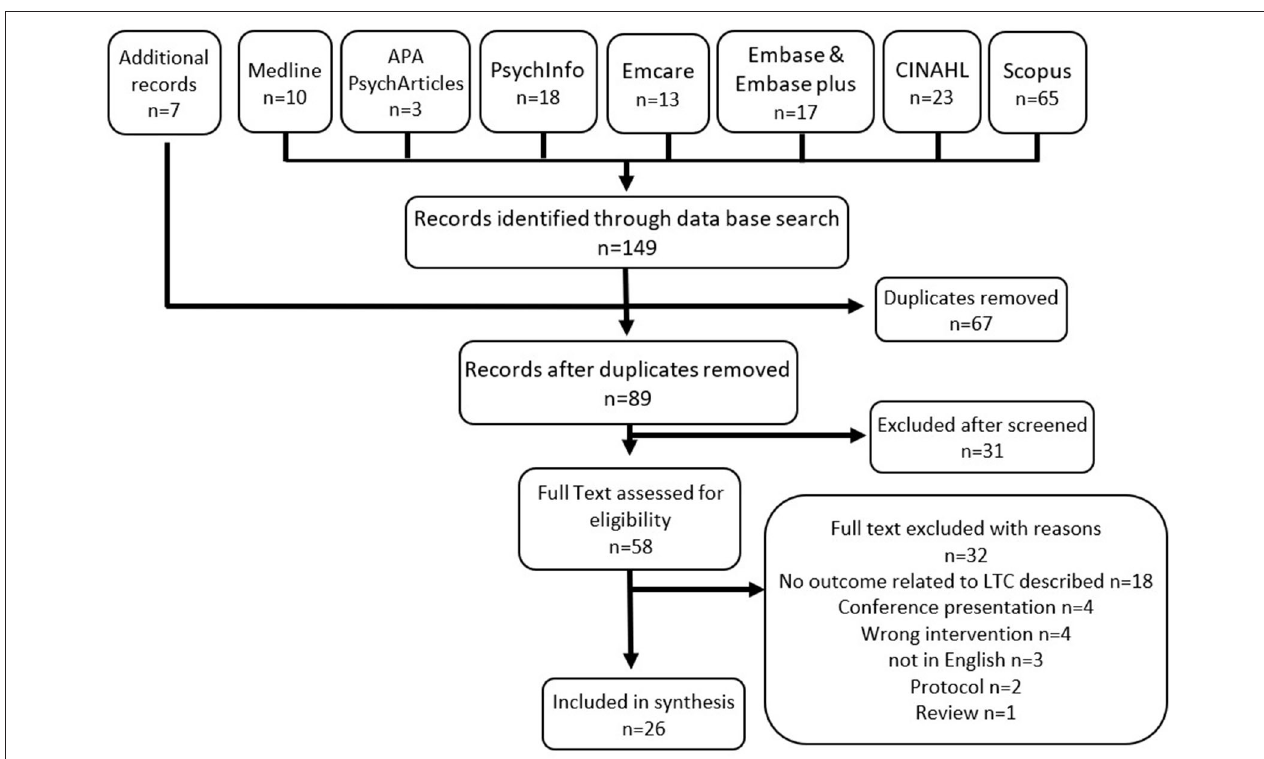
FIGURE 1 | Search and